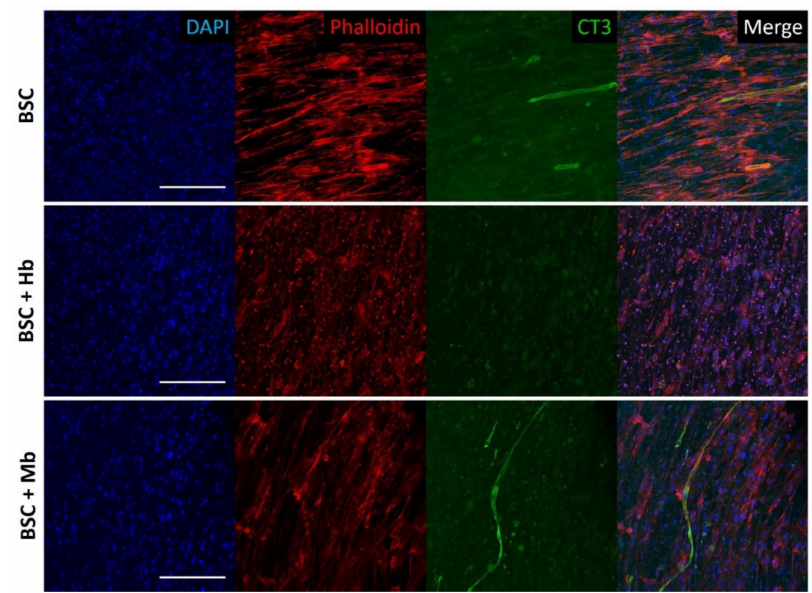
Figure 4. Confocal immunofluorescent imaging of BAMs. BAMs generated from BSC, BSC + Hb, or BSC + Mb (3 mg / mL for both heme proteins) were stained after eight days of di ff erentiation for DAPI, actin cytoskeleton (Phalloidin), and Troponin T (CT3), a marker of myogenesis. Images show multinucleated myotube formation in BSC and BSC + Mb constructs, though not in BSC + Hb constructs. Scale bars are 200 µ m.